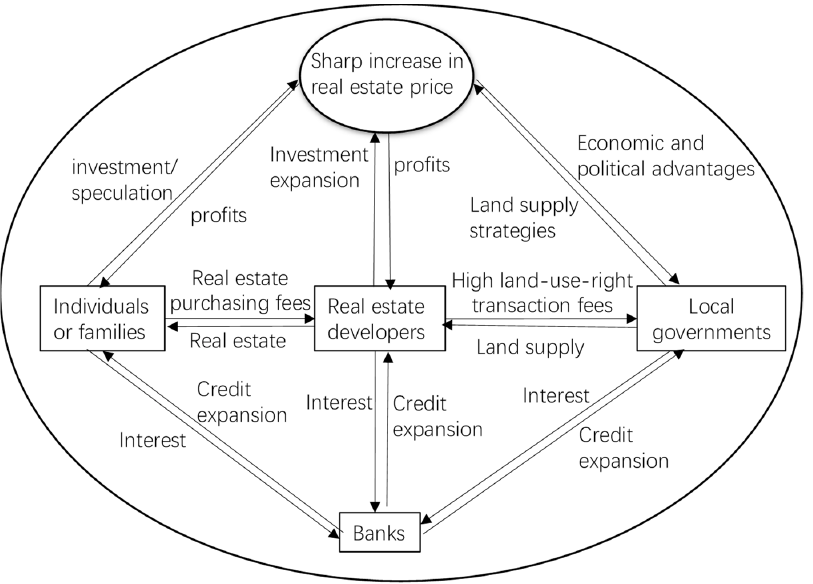
Figure 1. How various sectors promote the increase in real estate price. Source: Liu et al. (2018).